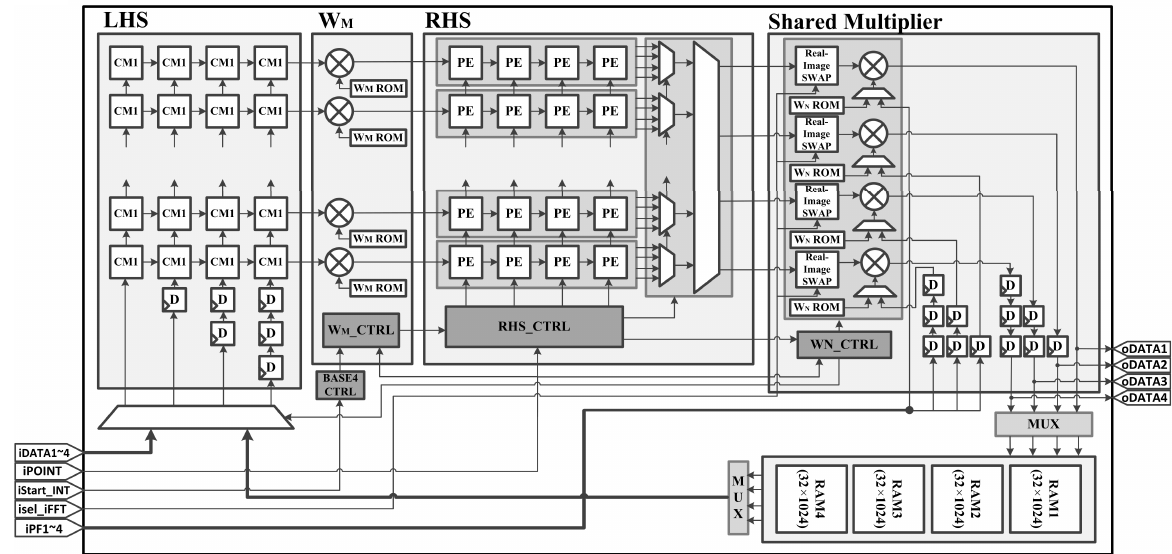
Figure 6. Hardware architecture of the proposed CSA-based SAR